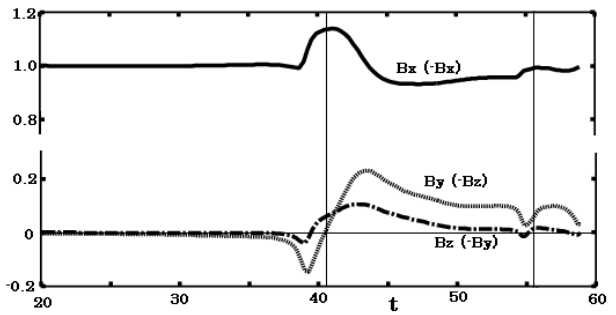
Fig. 6. Temporal variations of magnetic fields observed by virtual satellites located in the magnetic field (low- β ) region, where B x ,B y and B z in the simulation coordinates correspond to − B x , − B z and − B y , respectively, in GSM coordinates.